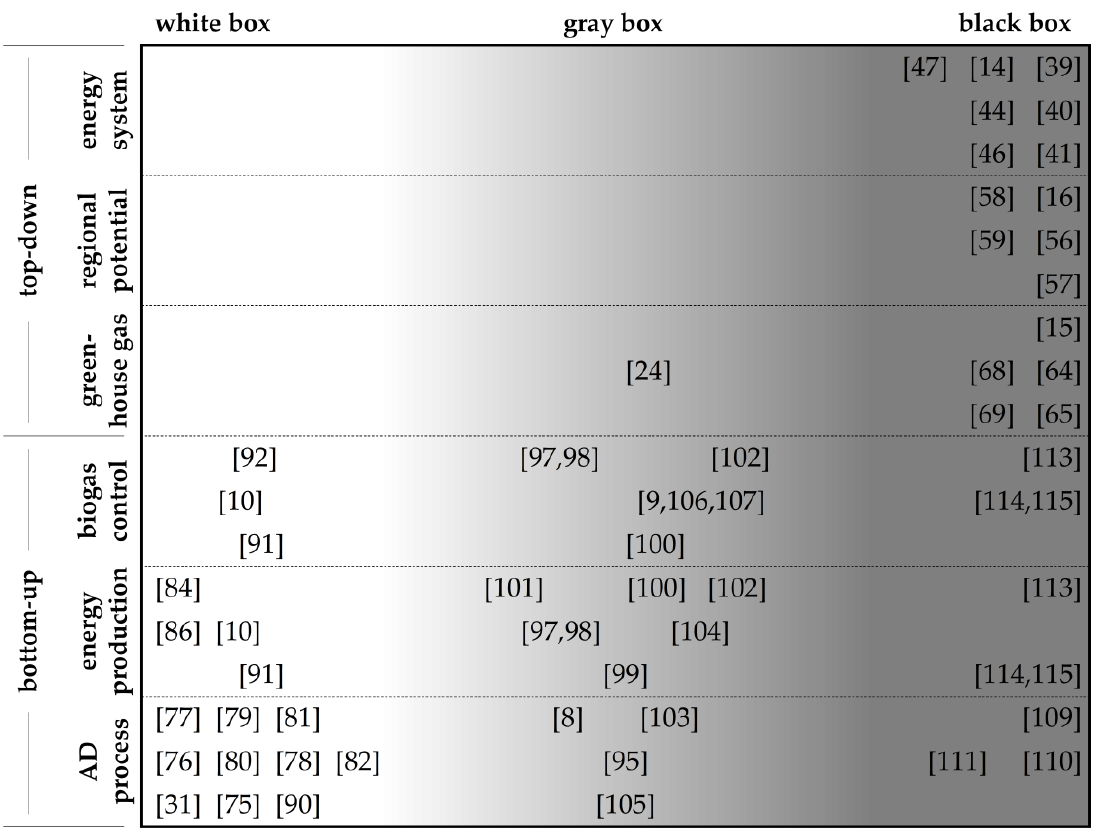
Figure 5. Classification of the references regarding their respective level of detail and field of application.